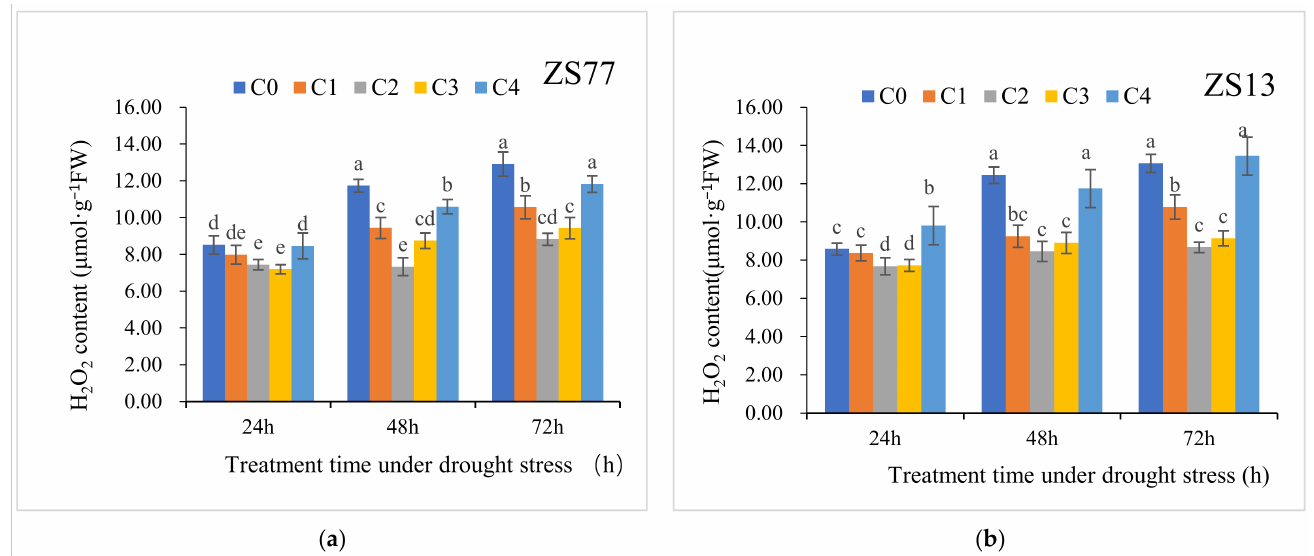
Figure 3. Effect of different concentrations of exogenous SA solution 0 (C0), 1.00 (C1), 2.00 (C2), 4.00 (C3), and 8.00 mg · L − 1 (C4) on H 2 O 2 content of sweet-potato leaves under drought stress. Bars with different letters indicate significant differences among treatments at 0.05 level (Duncan).